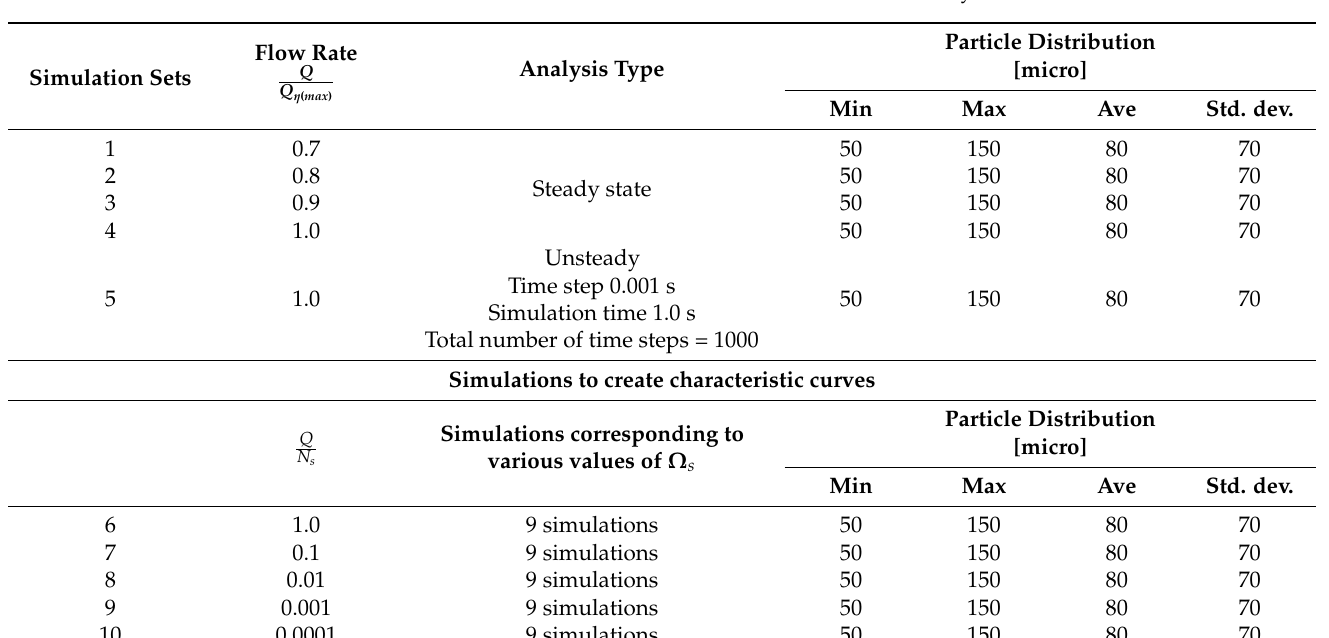
Table 7. List of the simulations conducted for the current